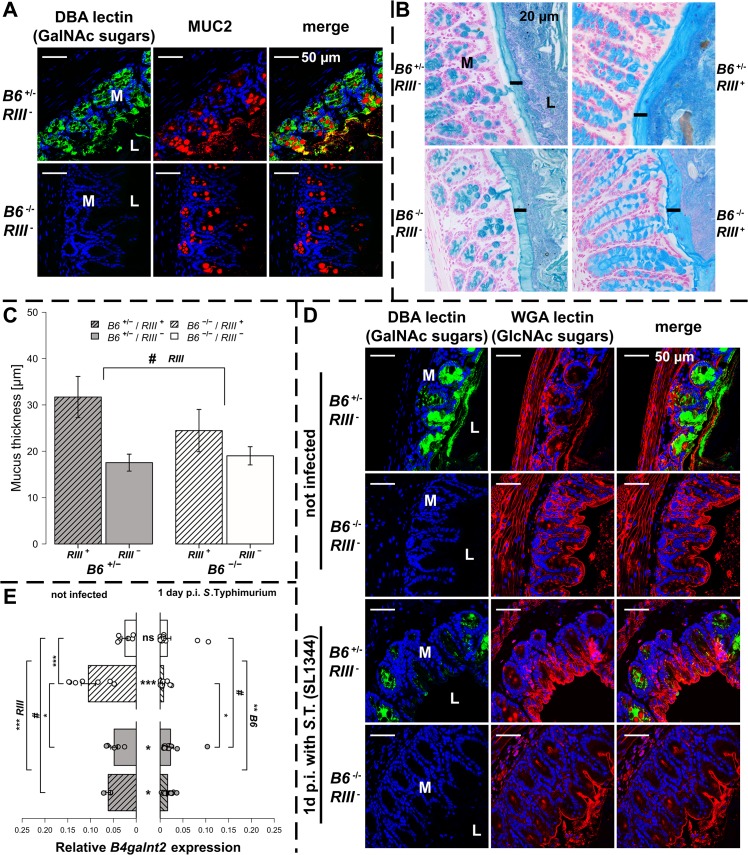

B4galnt2 glycosylation in S. Typhimurium-induced colitis.(A) MUC2 (red) and DBA lectin (green) staining in formalin fixed cecal tissue sections (B) Acidic mucus was stained with alcian blue in Carnoy’s-fixed tissue sections (bar = 20 μm). (C) Mucus thickness was determined at five different regions within one animal from which mean values were analysed (N = 3–5; Z = -1.807, P = 0.0816; Wilcoxon test via Monte-Carlo resampling). (D) B4galnt2 glycan residues (GalNAc) were stained with fluorescein labeled DBA (green) in formalin fixed cecal tissue sections before and 1 day p.i. with S. Typhimurium. GlcNAc residues were stained with Alexa633 labeled Wheat Germ Agglutinin (WGA) (red). (E) Relative expression of B4galnt2 before and after infection with S. Typhimurium showing significant differences between B6 and RIII genotypes before infection (B6: F
1,17 = 0.216, P = 0.64779; RIII: F
1,17 = 23.959, P = 0.00014; B6/RIII: F
1,17 = 7.687, P = 0.01304 [pairwise comparisons- B6
-/-/RIII
+|B6
-/-/RIII
-: P = 0.00018, B6
+/-/RIII
+|B6
-/-/RIII
-: P = 0.08626, B6
-/-/RIII
+|B6
+/-/RIII
-: P = 0.02673]; Linear model and Tukey post-hoc test) and B6 genotype differences after infection (F
1,53 = 11.787, P = 0.001165). Infection has additional influence on B4galnt2 expression (Z = 5.268, P<0.00001, Wilcoxon test via Monte-Carlo resampling), which is also genotype specific (B6
+/-/RIII
+: Z = 2.6458, P
Bonferroni = 0.01192, B6
+/-/RIII
-: Z = 2.6122, P
Bonferroni = 0.02832; B6
-/-/RIII
+: Z = 3.5496, P
Bonferroni = 0.00016, B6
-/-/RIII
-: Z = 2.0642, P
Bonferroni = 0.16132; Wilcoxon test via Monte-Carlo resampling; # P < 0.100, * P < 0.050, ** P < 0.010, *** P < 0.001; error bars indicate SEM).